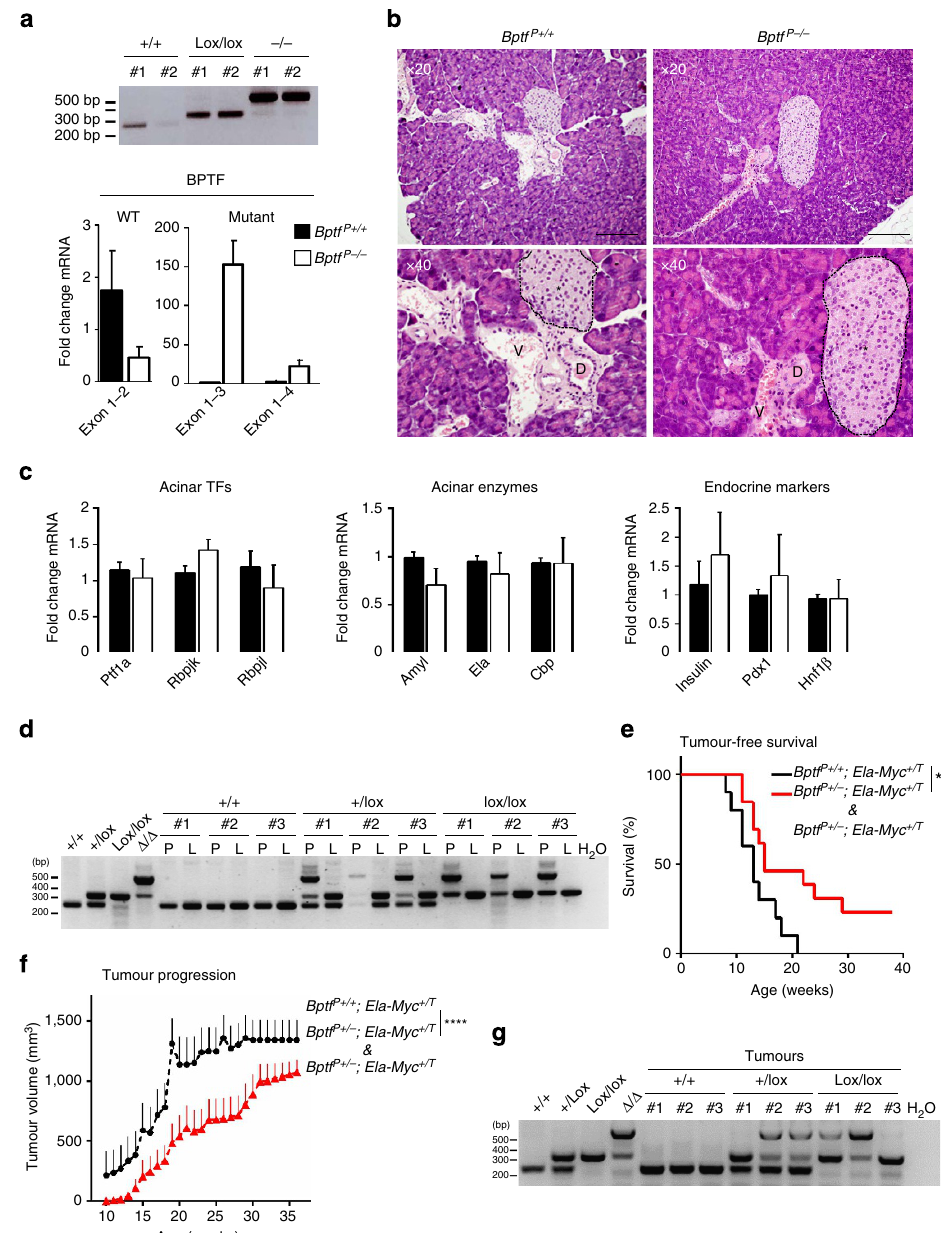
Figure 7 | BPTF is dispensable for pancreatic differentiation but its inactivation delays the onset and progression of c-MYC-driven pancreatic tumors. ( a ) PCR on genomic DNA showing efficient recombination at the Bptf locus in Bptf P (cid:3) / (cid:3) pancreas (top). RT–qPCR analysis of BPTF WTand mutant mRNA species in control ( n ¼ 6) and Bptf P (cid:3) / (cid:3) ( n ¼ 7) mice (bottom). Transcript levels were normalized against actin and the WTcondition. ( b ) Haematoxylin– eosin staining of WTand Bptf P (cid:3) / (cid:3) mouse pancreatic sections. D, duct; V, blood vessel; *, islet of langerhans. Scale bar, 200 m m. ( c ) mRNA expression of acinar transcription factors, digestive enzymes and endocrine markers in pancreata of WTand Bptf P (cid:3) / (cid:3) mice assessed by RT–qPCR ( n ¼ 3 per genotype). Transcript levels were normalized against actin and the WTcondition. ( d ) PCR on pancreas (P) genomic DNA assessing the extent of recombination at the Bptf locus in 5–7-week-old Ptf1a-CreERT2 þ /KI ;Ela-Myc mice of the corresponding genotypes. Liver (L) samples were used as negative